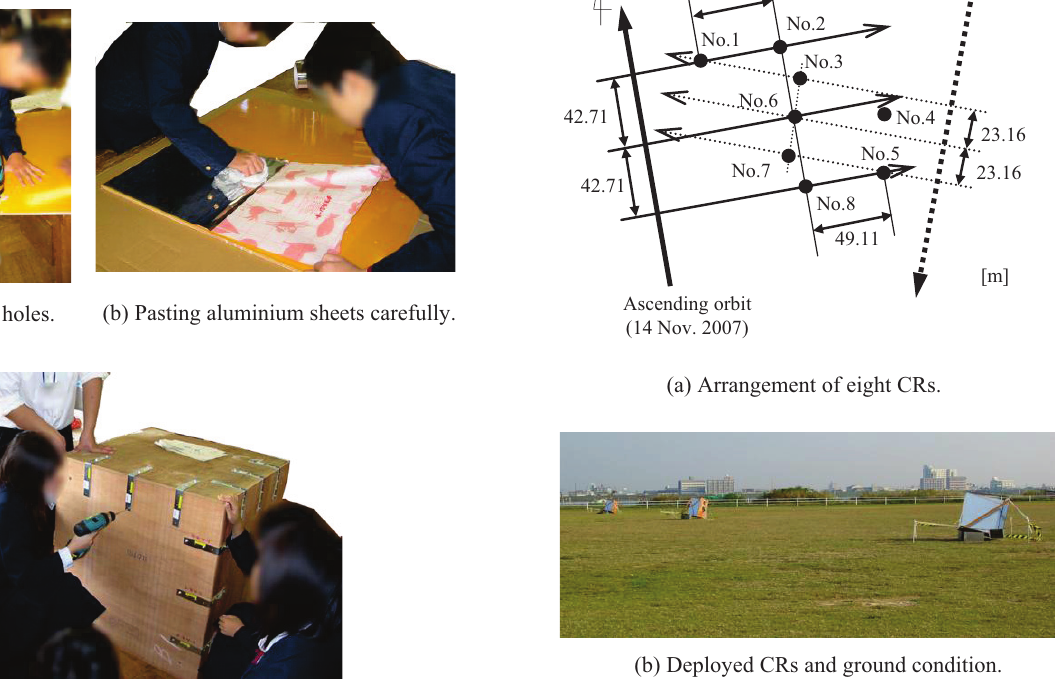
Descending orbit (15 Nov.